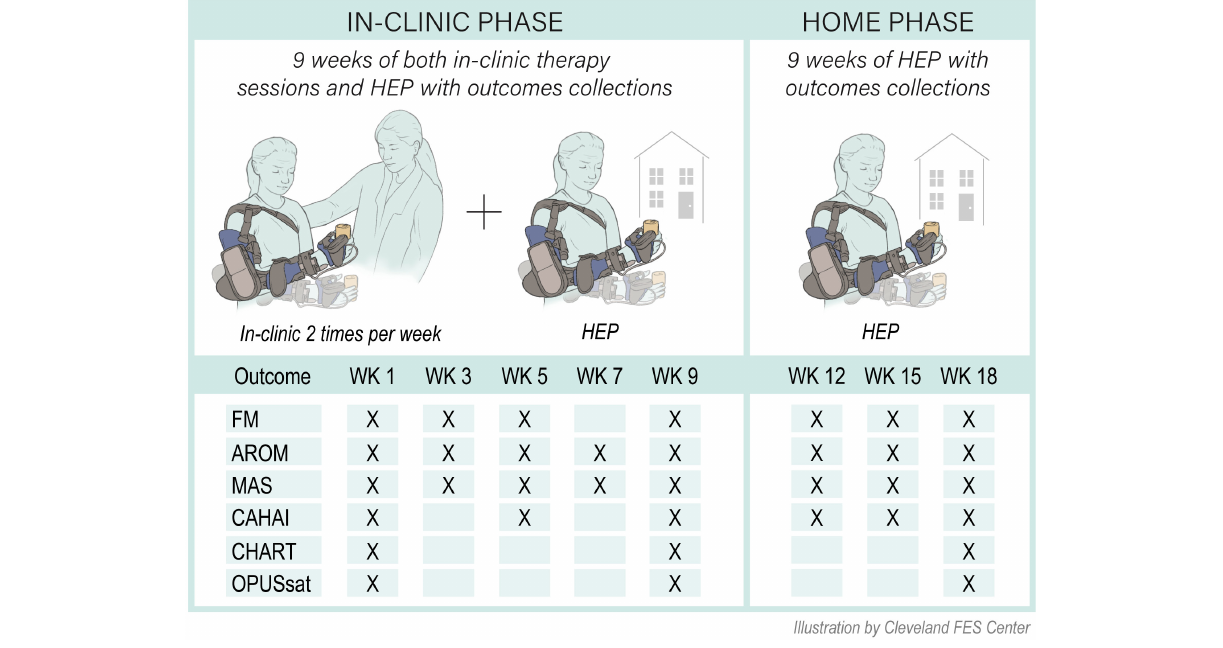
FIGURE 1 | Study overview. FM, Fugl-Meyer for upper limb; MAS, Modified Ashworth Scale; ROM, active range of motion; CAHAI, Chedoke Arm and Hand Inventory; CHART, Craig Handicap Assessment and Rehabilitation Tool; OPUSsat, Orthotic and Prosthetic User’s Survey Satisfaction Module; HEP, home exercise program; WK,